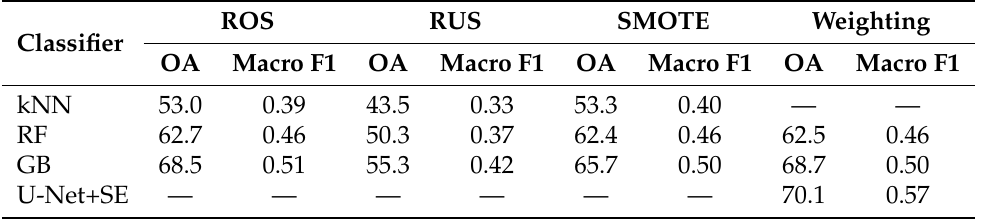
Table 2. Comparison of resampling techniques and pixel-wise classification results for ML models and U-net before pixel aggregation. The table does not contain metrics for resampling methods incompatible with some algorithms. For example, ROS, RUS, and SMOTE methods are not applicable for CNN, and weighting is not for